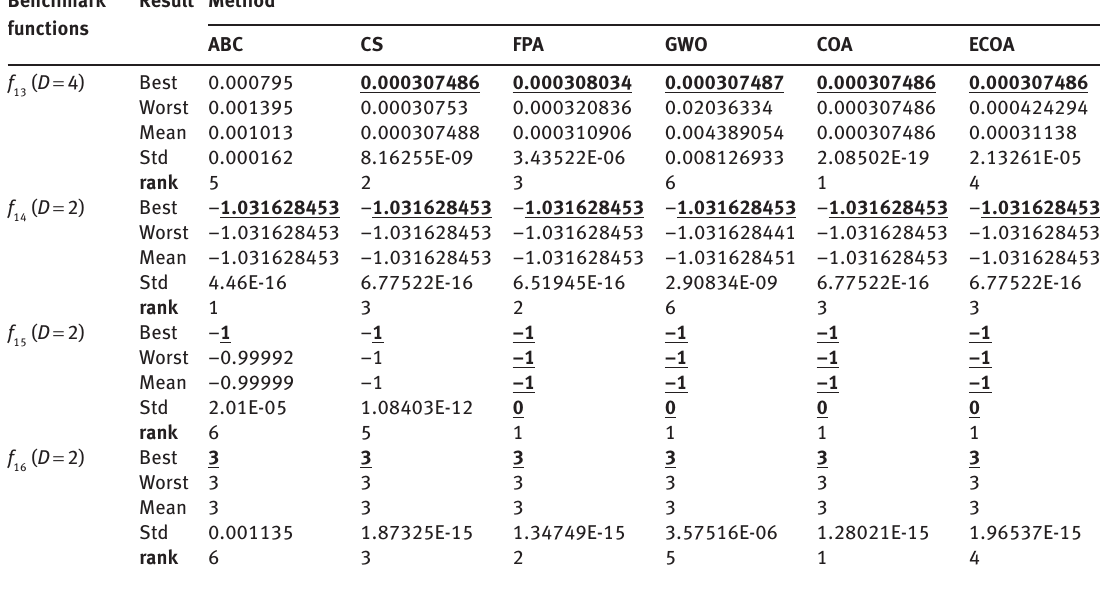
, i = 13, 14, 15, 16, 17, 18, 19, 20, 21, 22, 23. i